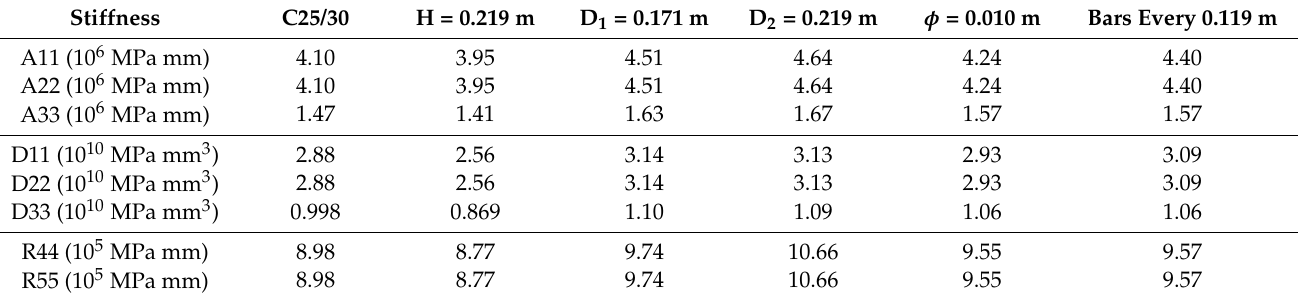
Table 7. Stiffness for RVE BD230 in case of decreasing the value of individual cross-section